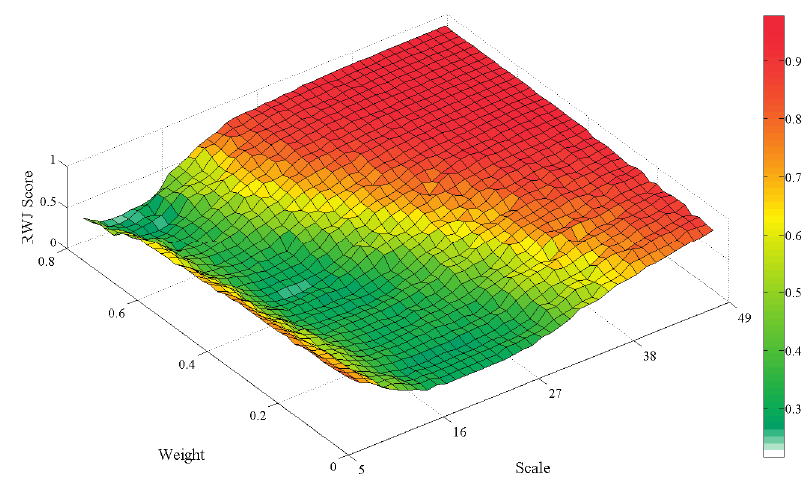
Figure 19. Search landscape slice with the Scale and probability weighting parameter of the Hybrid:CP method